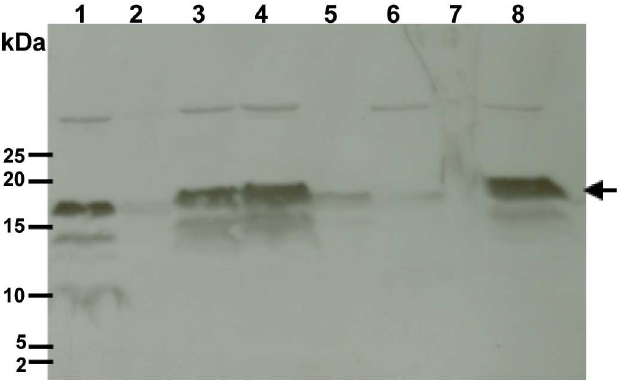
Fig 3. Vpu fractionates with the water insoluble fraction and can be subsequently solubilized by detergents. Whole cell lysates of E . coli BL21s expressingVpu were fractionatedinto non- aqueous (lane 1) and aqueous (lane 2) fractions by centrifugation. The non-aqueous fraction (pellets) were resuspended in extraction buffer containing variousdetergents (1% final concentration): β DM (lane 3), β DDM (lane 4), CHAPS (lane 5), OG (lane 6), LDAO (lane 7) and DPC (lane 8). Followingovernight incubationat 4˚C, detergent-solubleproteins were separatedfrom insolubleproteins by centrifugation and fractionated by SDS-PAGE followedby immunoblot analysisusing a Vpu-specific antibody.Vpu is indicatedby a black